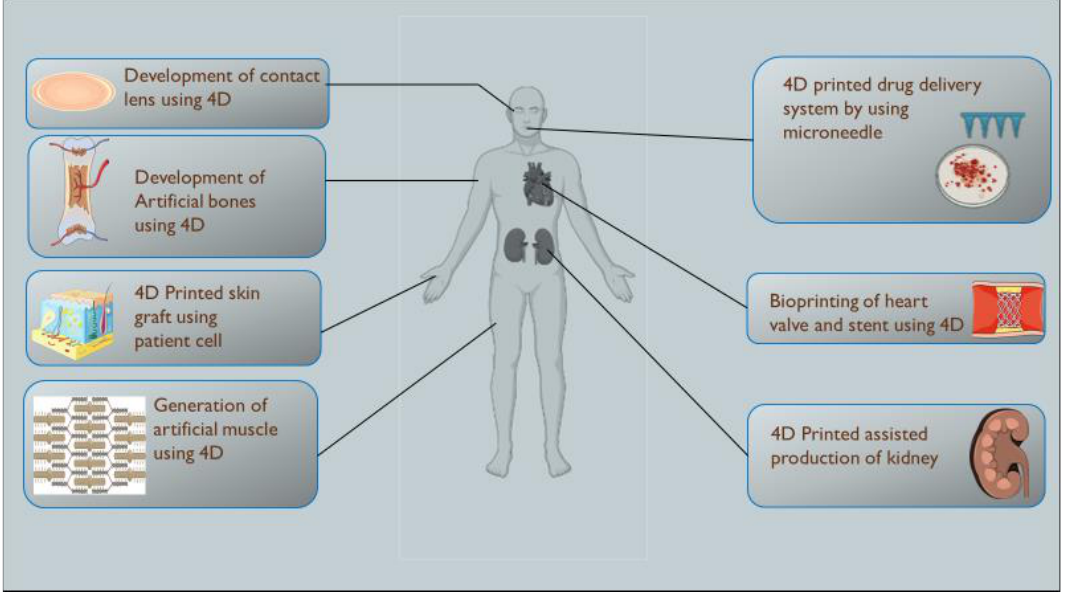
Figure 3. Application of 4D Printing in Healthcare which includes 4D printed organs, implants, tissue, etc.